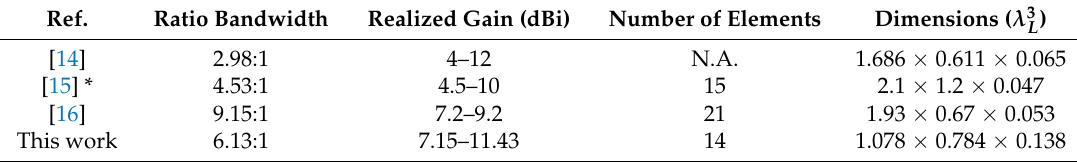
Table 3. Performance Comparison with Previous Wideband Low-Profile Antennas.